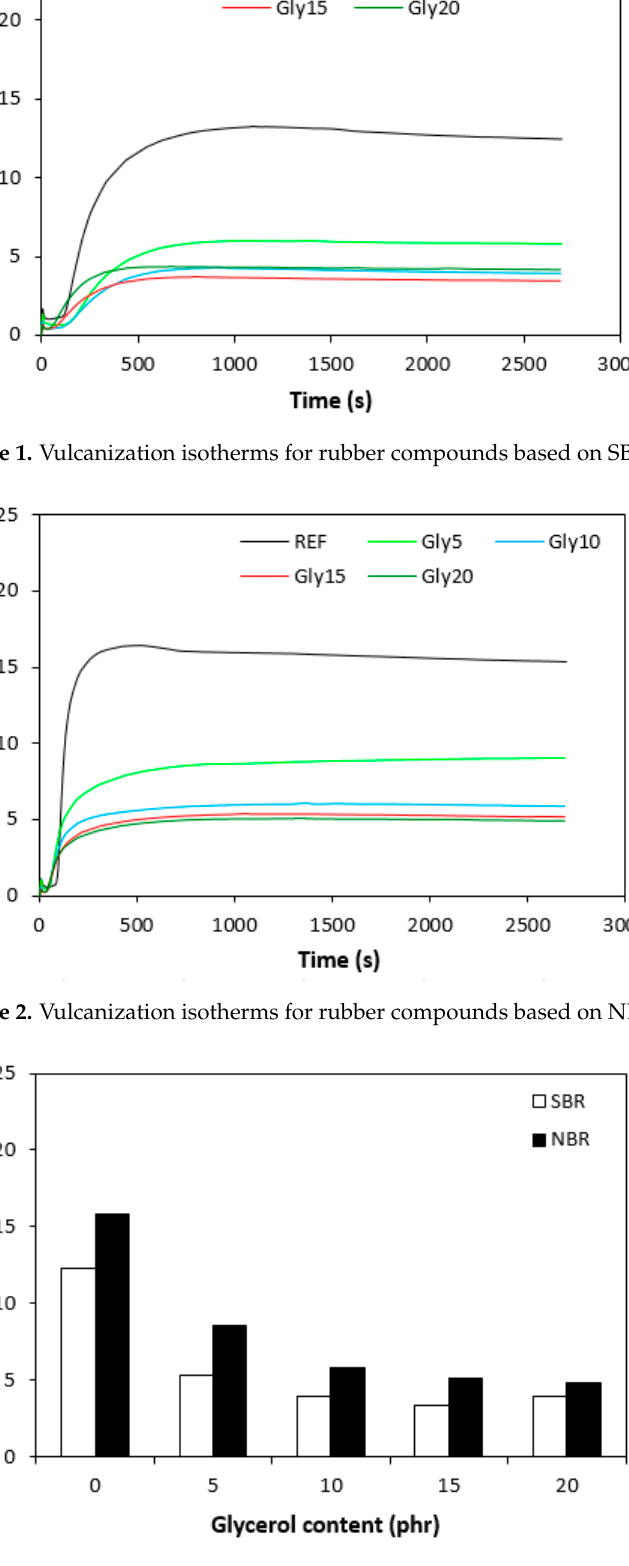
Figure 3. Influence of glycerol content on torque difference ( Δ M) of rubber compounds.